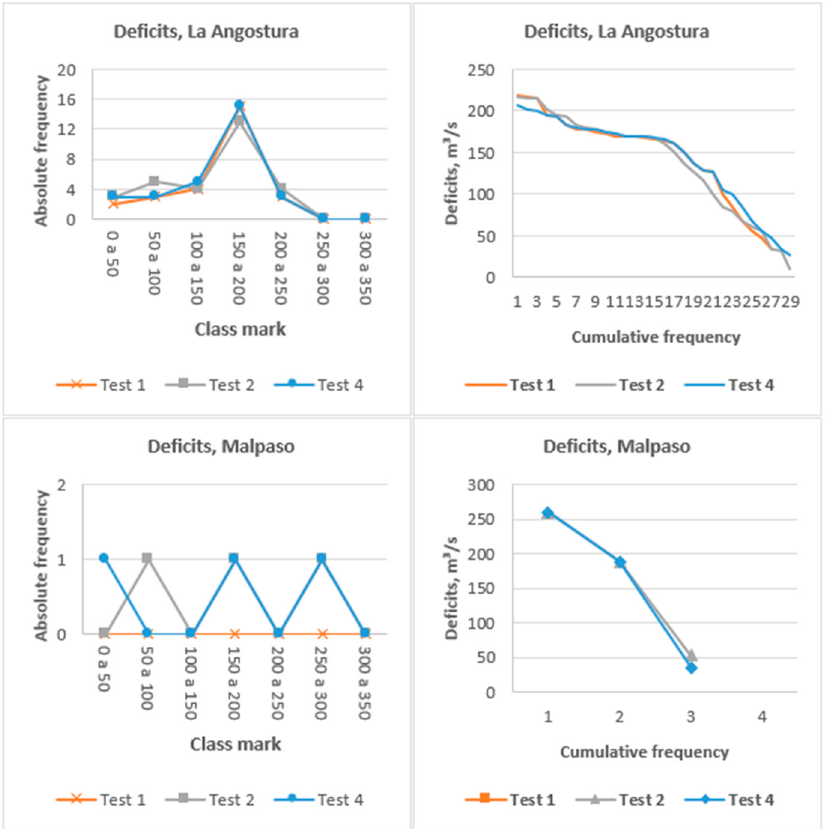
Figure 13. Deficit count with the combined guide curve policy.